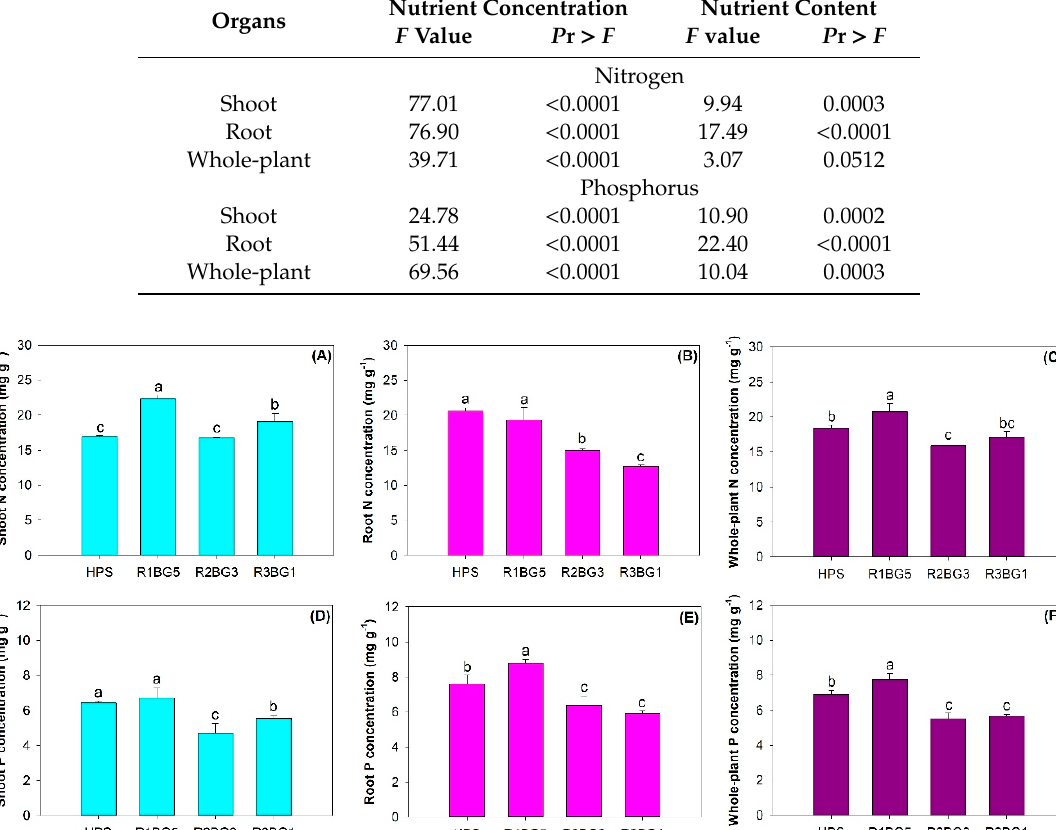
Figure 5. Nitrogen (N) (top) and phosphorus (P) (bottom) concentrations in shoots (left), roots (middle), and the whole plant (right) of Korean pine ( Pinus koraiensis ) seedlings under three LED-spectra treatments (R1BG5, R2BG3, and R3BG1) with the HPS spectrum as the control. Di ff erent letters indicate significant di ff erence according to Tukey’s test at the 0.05 level. Subfigures A – C present N concentration in shoot, root, and whole-plant, respectively. Subfigures D – F present P concentration in shoot, root, and whole-plant, respectively.